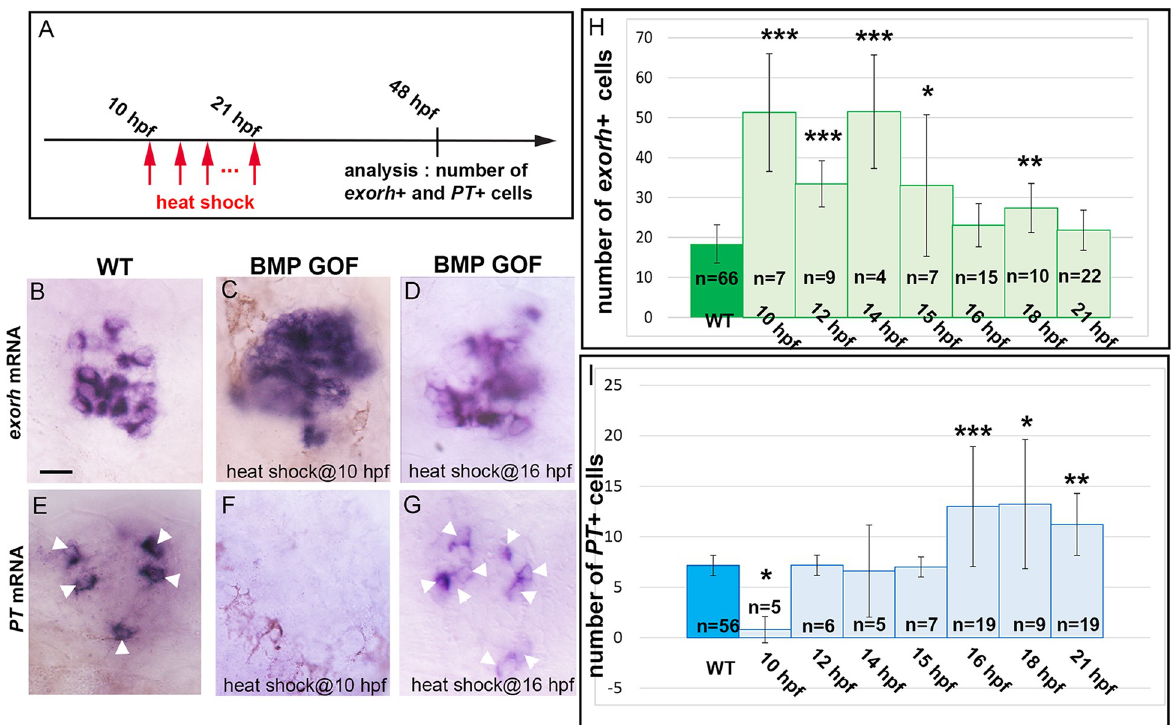
Fig 7. Activation of BMP signaling at different times affects PhR subtype identity. (A) Scheme of the experimental design showing the timing of the heat shocks and analysis of the number of exorh+ and PT + cells. (B-G) In situ hybridization for exorh and PT in 48-hpf WT and Tg(hsp70 : bmp2b) fr13 transgenic embryos (BMP GOF) heat shocked at 10 or 16 hpf. Embryos are viewed dorsally with anterior to the top. Scale bar represents 10 μ m. (H-I) Counts of exorh+ and PT + cells in WT and Tg(hsp70 : bmp2b) fr13 embryos after a heat shock performed at various stages (indicated on the x-axis). Error bars represent SD. � p < 0.05. �� p < 0.001. ��� p < 0.0005. ���� using a Kruskal-Wallis test with Dunn’s post hoc comparisons of the transgenic versus WT populations. Tg(hsp70 : bmp2b) fr13 transgenic embryos were labeled BMP GOF. Underlying data can be found in S1 Data. BMP, bone morphogenetic protein; exorh , exorhodopsin ; GOF, gain of function; hpf, hours post fertilization; PhR, photoreceptor; PT , parietopsin ; WT, wild type.